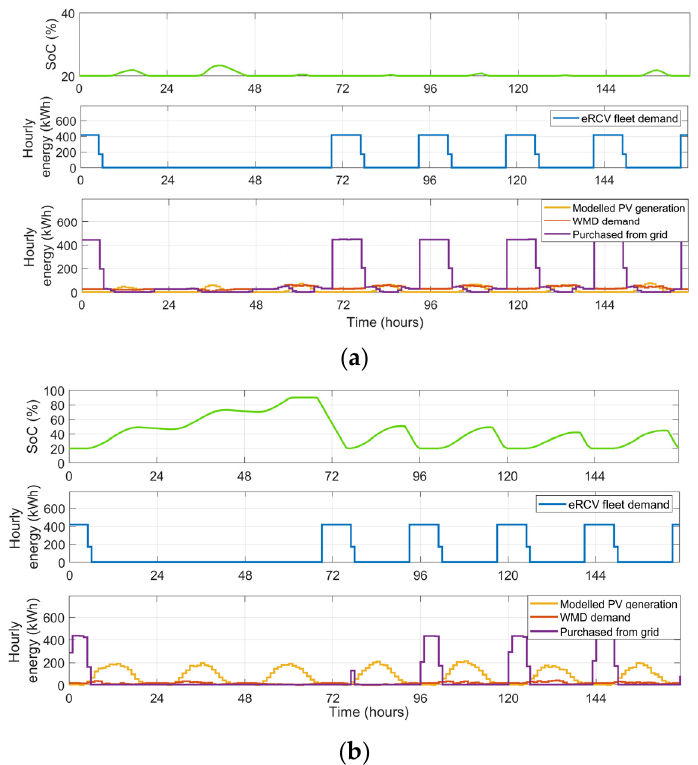
Figure 11. Hourly energy distribution for scenario 2 with a BESS capacity of 5 MWh in a week in ( a ) February and ( b ) July.